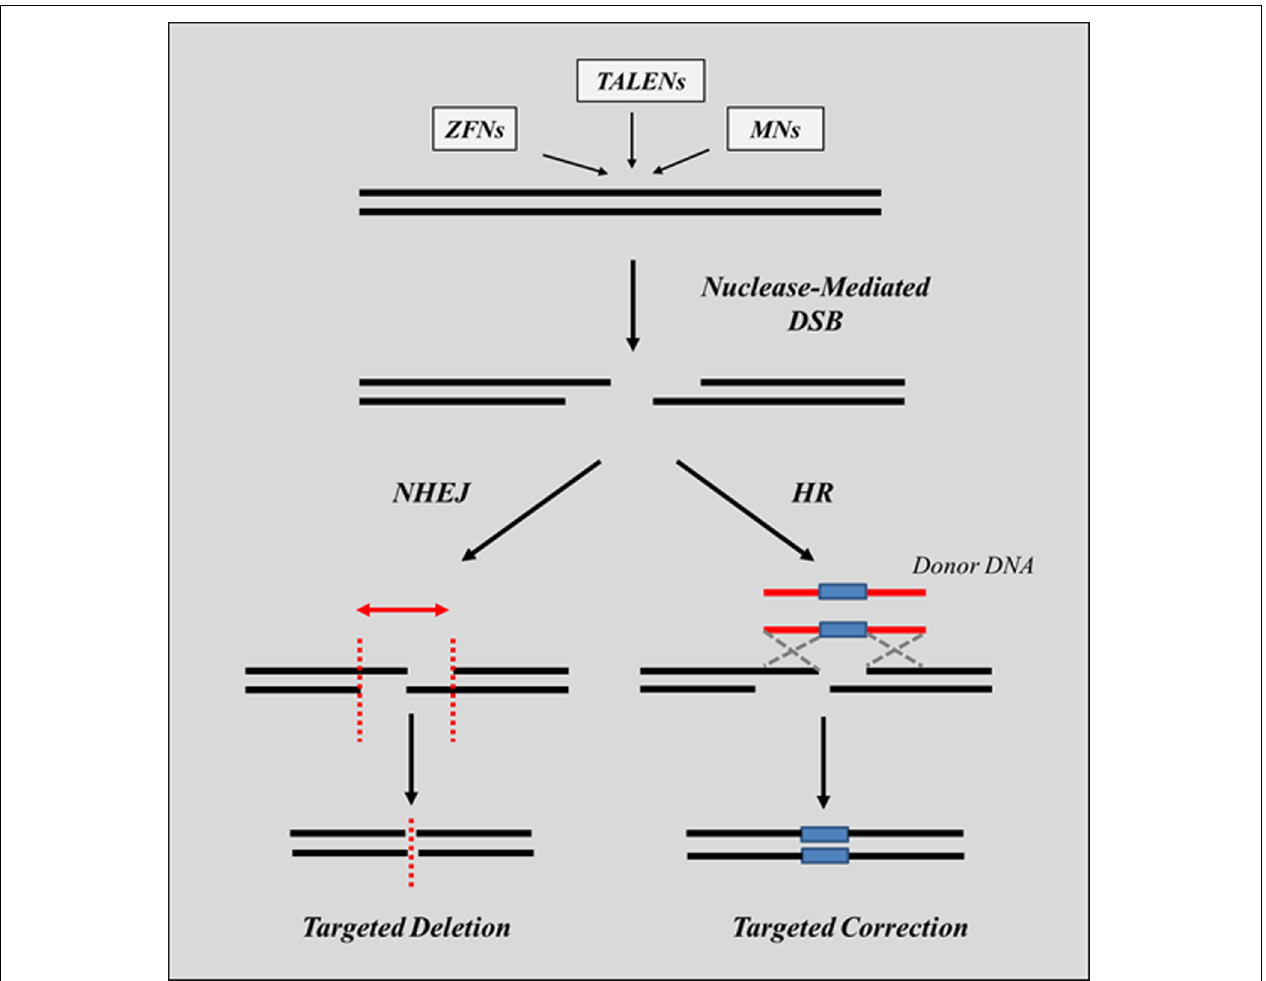
FIGURE 4 | Geneeditingusingnucleases. Uponintroductionintothecelland following recognition of the region of the genomic DNA targeted for repair, the bindingdomainsofthenucleasesassociateandgenerateaDSBwhichtriggers the activation of specific repair mechanisms. In the absence of donor DNA sequences, the break is repaired by the NHEJ repair pathway by cleaving non-compatible overhang sequences and by joining the ends of the cleaved sequences (targeted deletion). This usually results in deletions of one or more